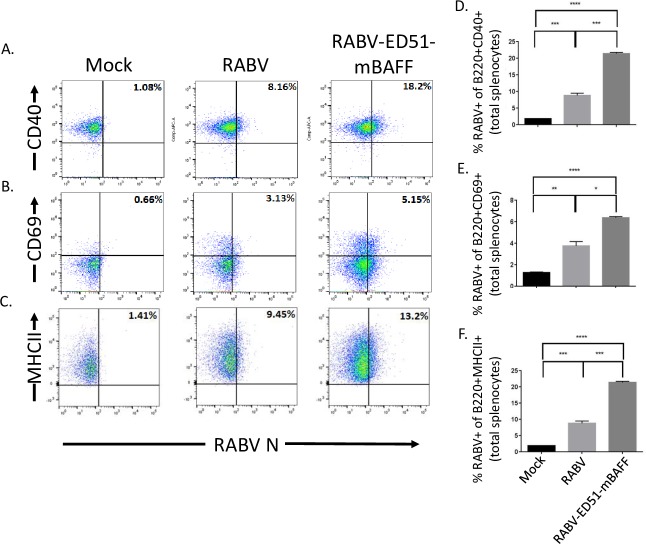
RABV-ED51-mBAFF activates primary murine B cells more effectively than RABV ex-vivo.Naïve primary murine splenocytes were infected at a MOI of 5 with RABV or RABV-ED51-mBAFF, or treated with medium alone (mock infected) for two days ex-vivo. No additional mitogens were added to the culture to avoid expressing activation molecules that could enhance sensitivity to RABV infection and activation. The cells were immunostained for cell-surface expression of B220 and the activation markers CD40, CD69, and MHCII, as well as immunostained internally for the presence of RABV N, which is indicative of infection. Representative gating strategy are shown for B220+ B cells gated on RABV N+ and CD40 (A), CD69 (B) or MHCII (C). The percentage of RABVN+CD40+ B cells (D), RABVN+CD69+ B cells (E) or RABVN+MHCII+ B cells (F) are indicated. To compare two groups of data, an unpaired, two-tailed Student’s t test was use (*p≤0.05; **p≤0.01; ***p≤0.001; ****p≤0.0001; N = 3 completed in duplicate).